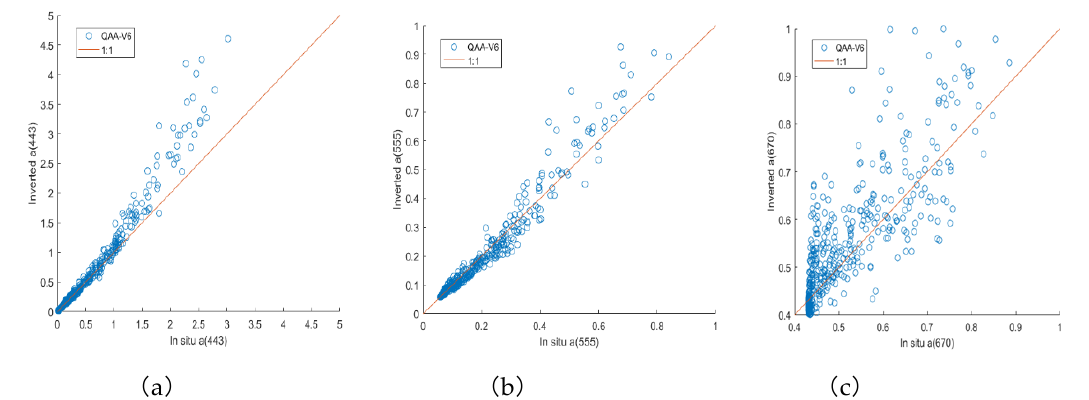
Figure 1. Performance of using QAA_V6 to invert the absorption coefficient at 443nm(a), 555nm(b) and